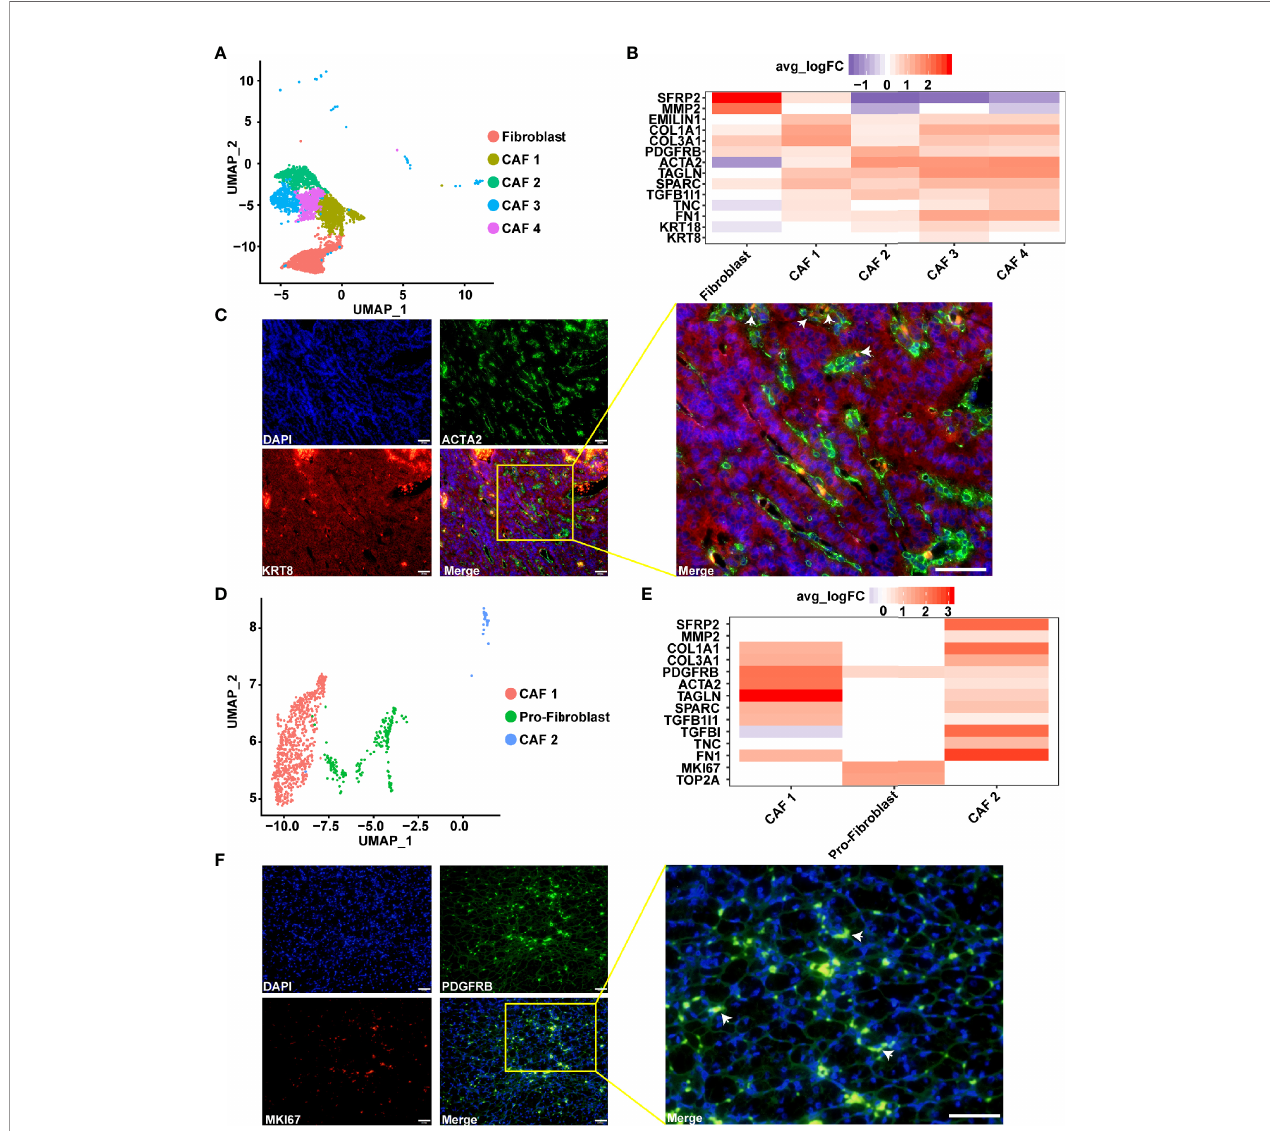
FIGURE 6 | Diversity of CAFs as identi fi ed using scRNA-seq. (A) UMAP plot showing the subpopulation of fi broblast in type 2 pRCC. (B) Gene expression characteristics of the fi broblasts in type 2 pRCC, including four types of CAF. (C) IF analysis of the expression of ACTA2 (green), which is a CAF marker, in combination with the epithelial cell marker KRT8 (red) and DNA staining using DAPI (blue) within the paraf fi n sections from human type 2 pRCC samples. CAF 3 (arrows) was veri fi ed using IF. Scale bars, 50 m m. (D) UMAP plot showing the subpopulation of fi broblast in ccRCC. (E) Gene expression characteristics of the fi broblasts in ccRCC, including two types of CAF and proliferative fi broblast (pro- fi broblast). (F) IF analysis of the expression of PDGFRB (green), which is a fi broblast marker, in combination with the marker MKI67 (red) and DNA staining using DAPI (blue) within the paraf fi n sections to verify the pro- fi broblast (arrows). Scale bars, 50 m